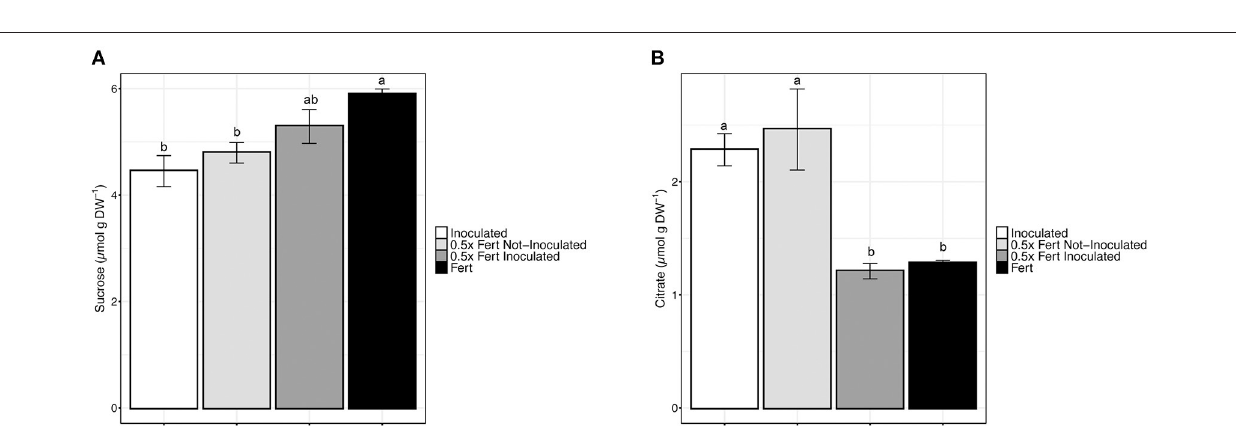
FIGURE 6 | Nutraceuticals content in cucumber fruits. (A) Concentration of sucrose in cucumber fruit harvested from plants cultivated for 60 days in greenhouse and subjected to the different fertilization treatments (i.e., Inoculated, 0.5x Fert Not-Inoculated, 0.5x Fert Inoculated, and Fert). (B) Concentration of citrate in cucumber fruit harvested from plants cultivated for 60 days in greenhouse and subjected to the different fertilization treatments (i.e., Inoculated, 0.5x Fert Not-Inoculated, 0.5x Fert Inoculated, and Fert). Data are reported as means ± SE. Different letters indicate significant differences according to one-way ANOVA with Tukey post-hoc tests ( p < 0.05). Letters were omitted when no significant differences were